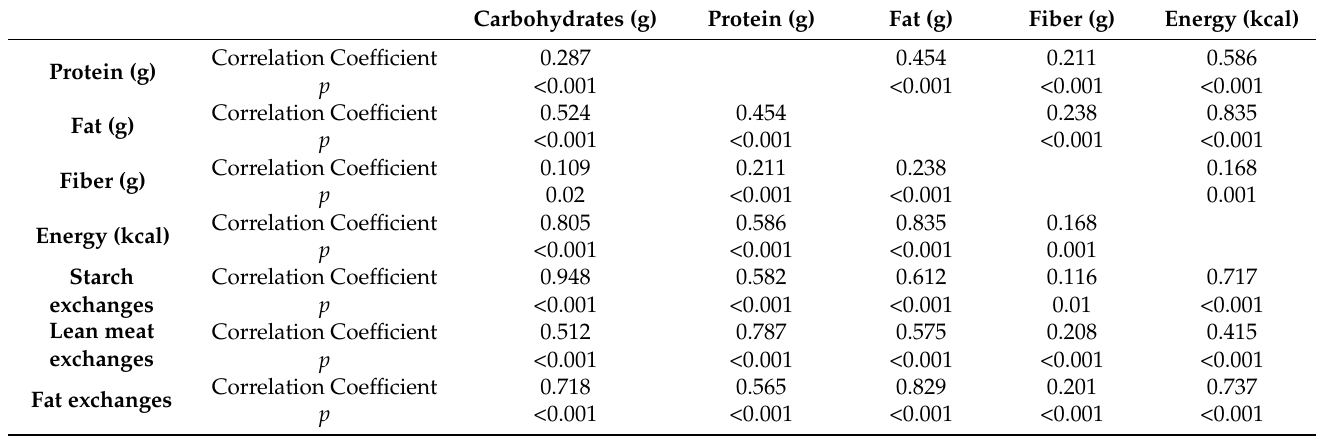
Table 2. Spearman correlation coefficients between macronutrient content and calculated food